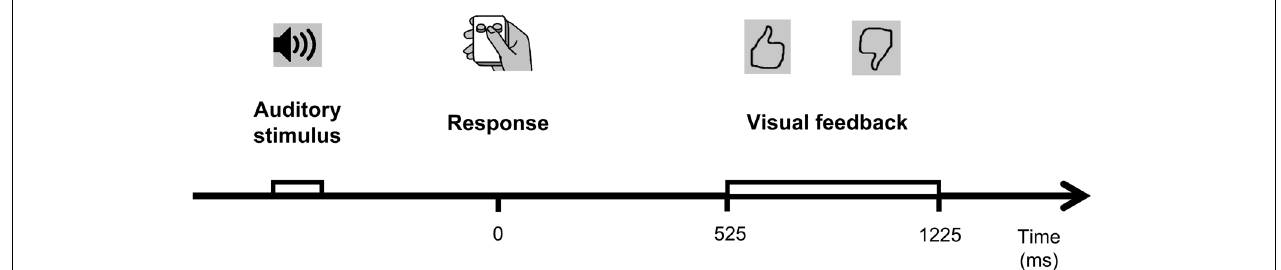
FIGURE 1 | A schematic illustration of the experimental behavioral task. See text for details.